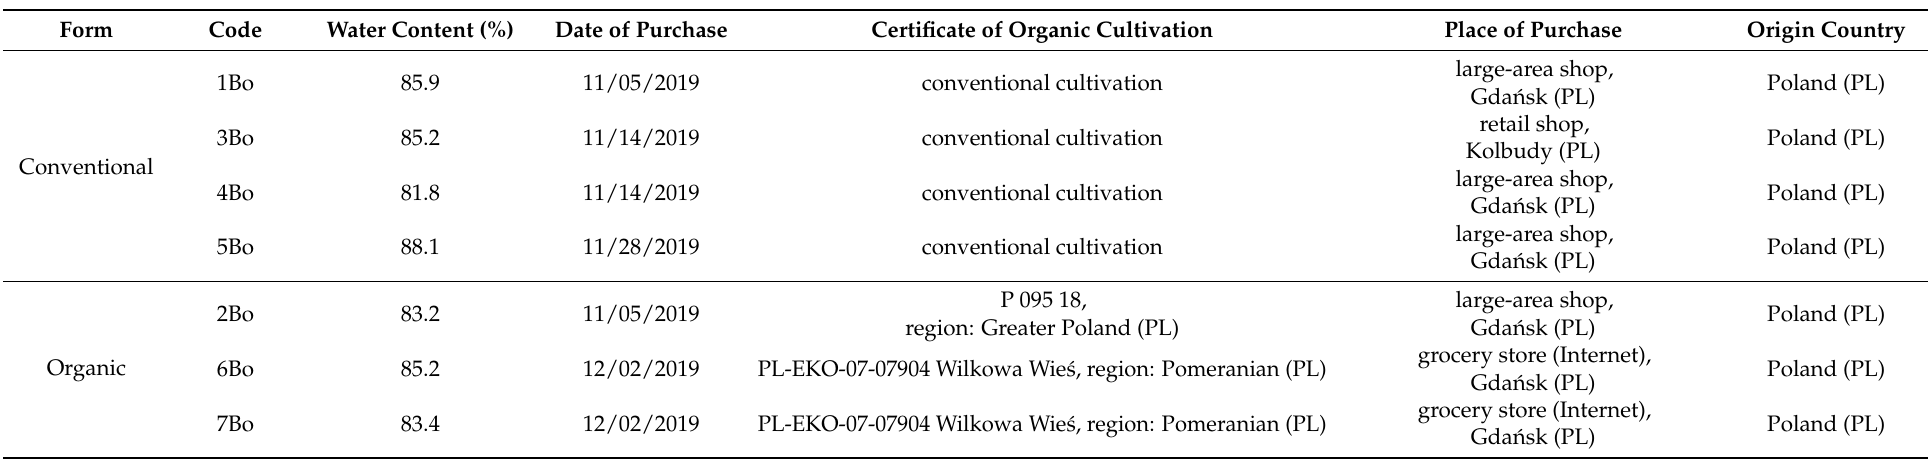
Table 1. Full characteristics of the analysed beetroot samples based on information in the place of purchase or